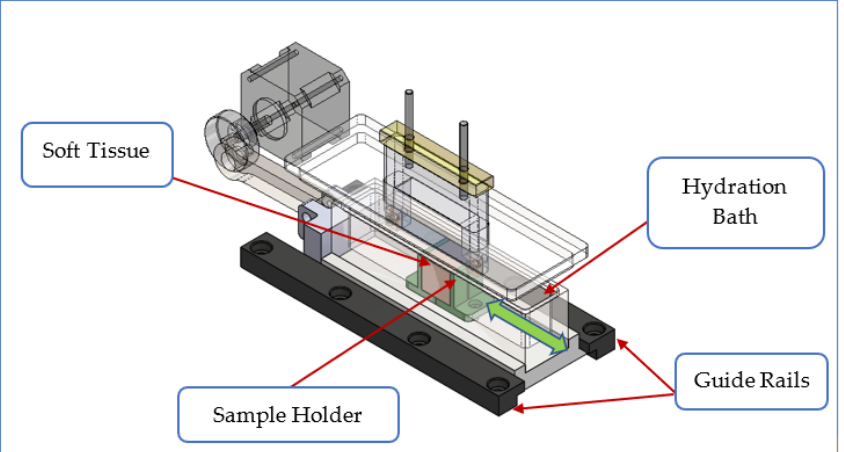
Figure 5. Soft tissue sample enclosed with X-axis only movement.